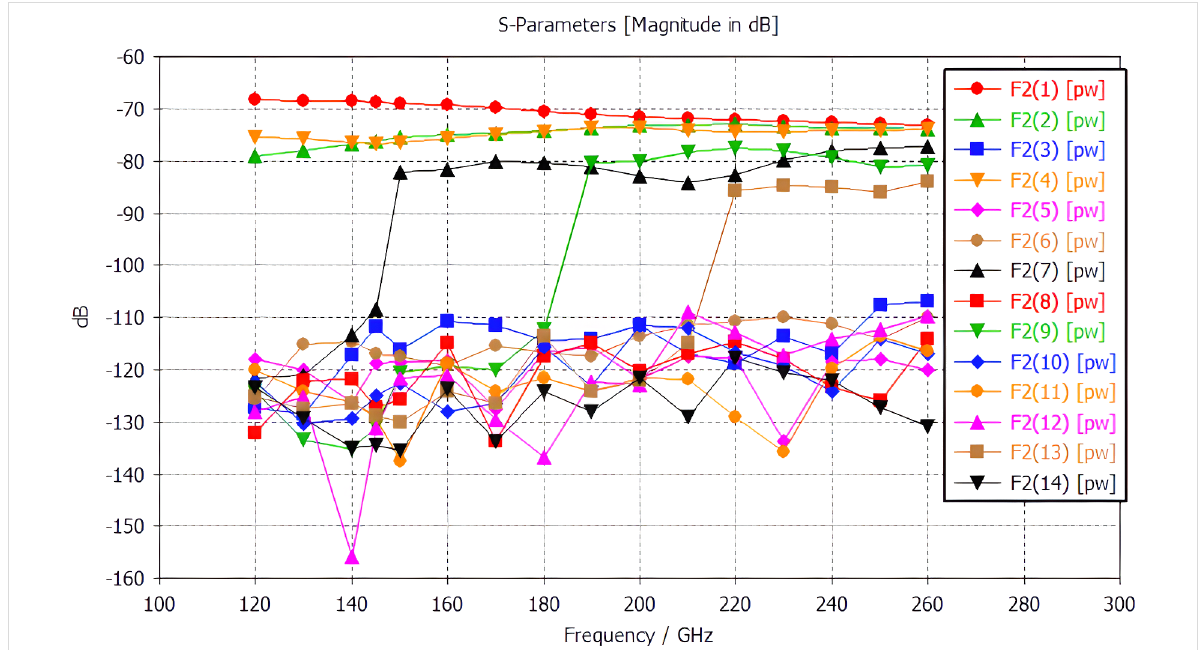
Figure 2: The mode composition of the electromagnetic field in the constriction of a bidirectional horn as a function of frequency.